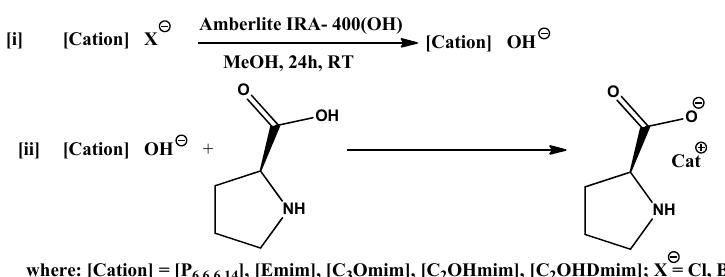
Figure 3. Synthesis of L-proline-based salts using ion exchange resins method.